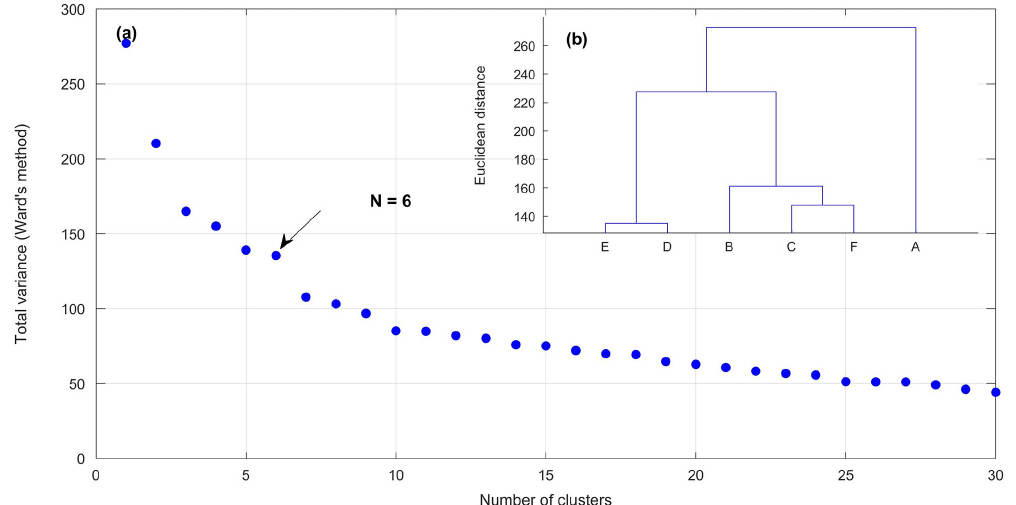
Figure 2. (a) Distance level at which two clusters are merged as a function of the number of clusters that result when the Ward linkage method is applied to daily dew yield data from 1979–2018. N is the optimal number of clusters that has been chosen for this study. (b) Dendrogram of 6